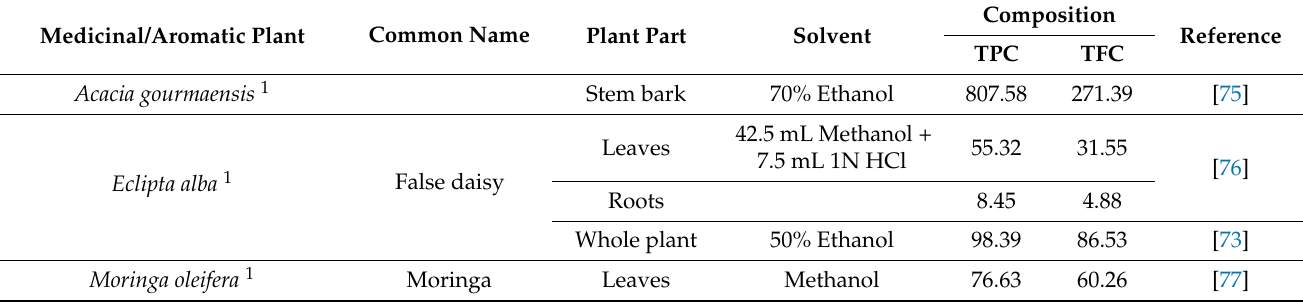
Table 2. Total Phenolic Contents (TPC) and Total Flavonoid Contents (TFC) of selected medicinal and aromatic plants. Medicinal/Aromatic